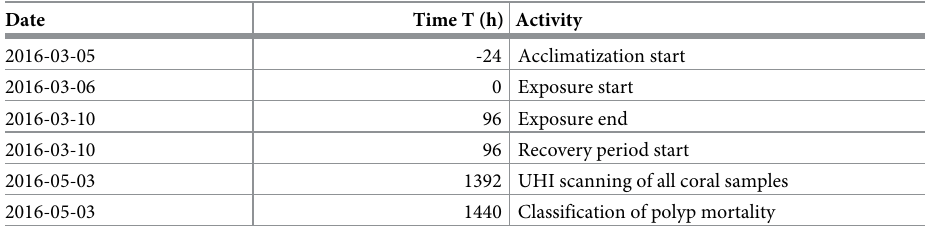
Table 1. Timeline of experimental